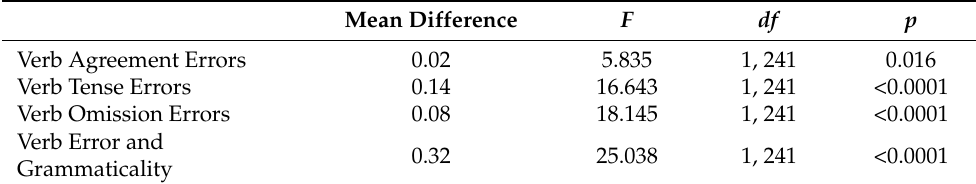
Table 4. EL and English-Proficient Students Verb Error